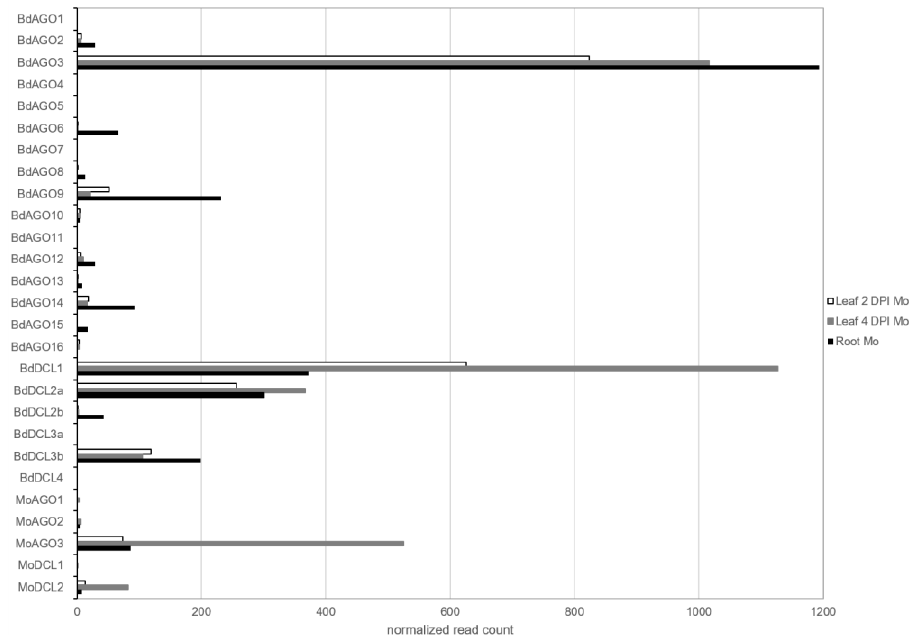
Figure 6. Expression of predicted ARGONAUTE (AGO) and DICER-like (DCL) during the interaction of B. distachyon and M. oryzae from mRNAseq results. Normalized read counts of each RNAi component were retrieved from DESeq2 analyses of infected datasets: leaf 2 DPI (white), leaf 4 DPI (grey) and root (black).